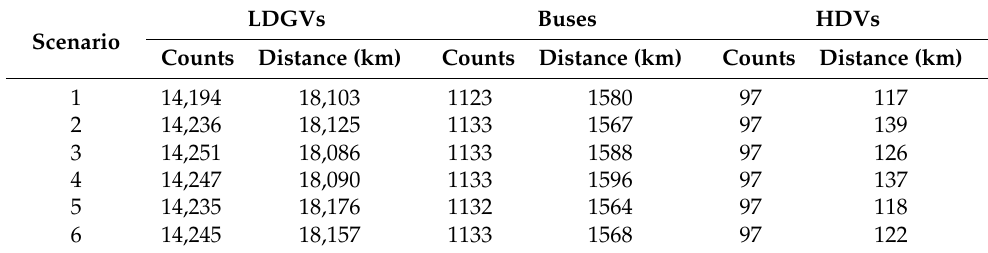
Table 7. Total number of vehicles and distances travelled within one hour. LDGVs Buses Scenario